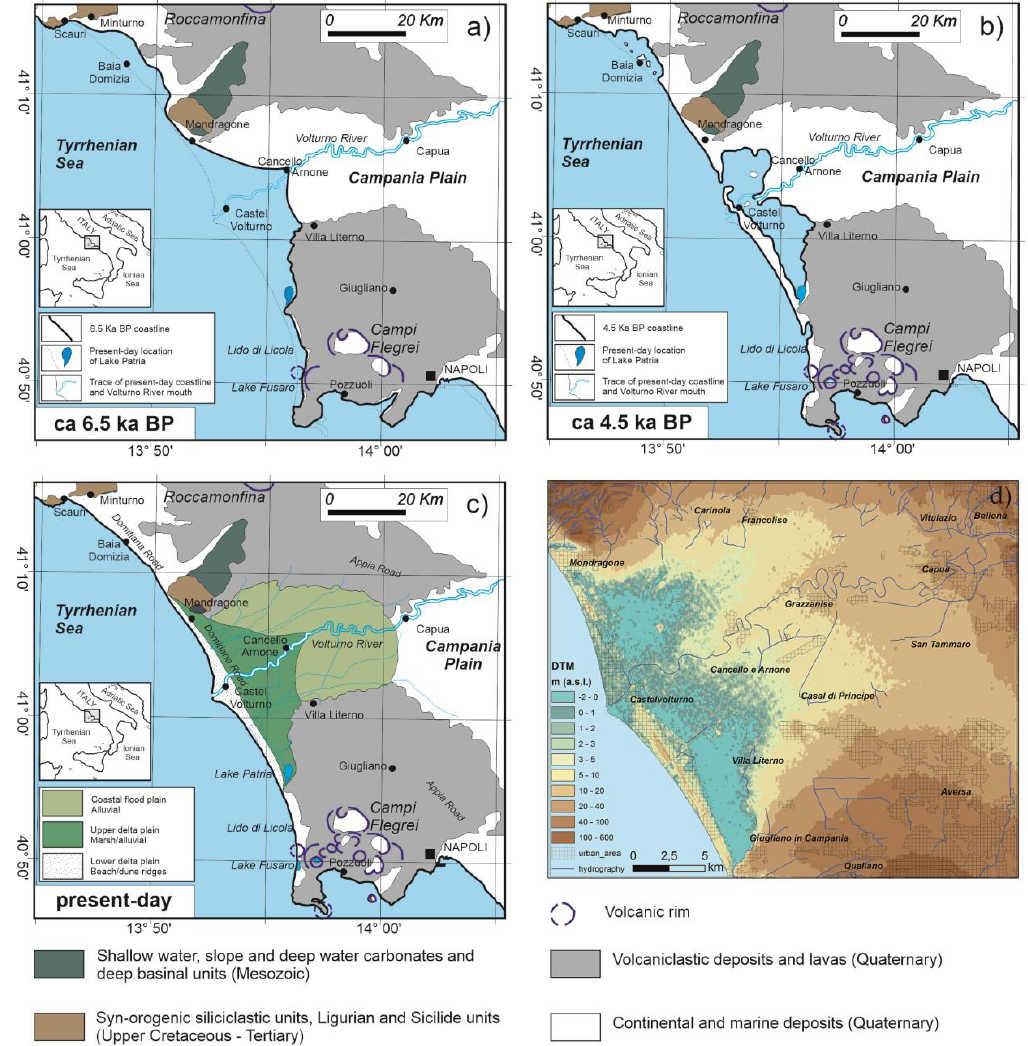
Figure 1. Sketch-map of the inferred evolution of the Volturno delta plain from the Late Holocene to present. (based on [30,31]): ( a ) reconstruction of the approximate location of coastline around the maximum marine ingression (ca. 6.5 ka BP; ( b ) coastline at ca. 4.5 ka BP, showing the onset of back-barrier lagoonal environments at the mouth of the Volturno River; ( c ) present day setting of the Volturno delta plain; ( d ) Digital Terrain Model with 70 m cell size.